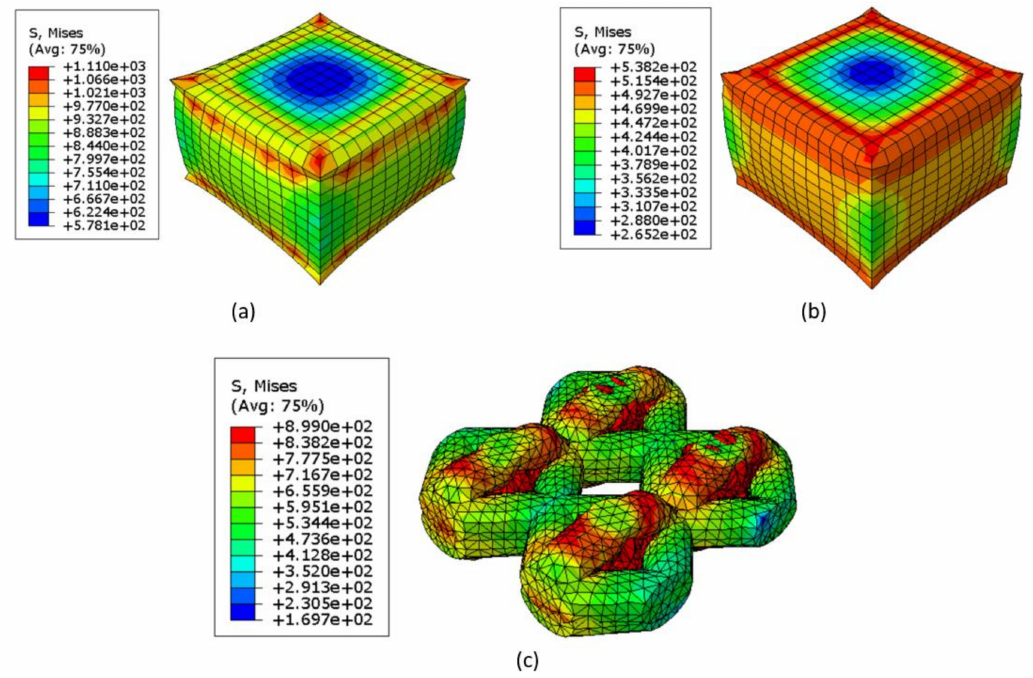
Figure 4. Deformation contour plots of FEA for compression samples: ( a ) bulk 316L stainless steel cube; ( b ) bulk dissolvable aluminum cube; ( c ) 316L stainless steel